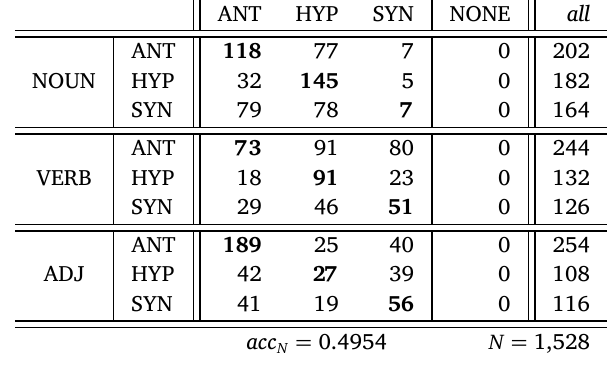
Confusion matrix for class assignment using lmi-based WINDOW-PROD features